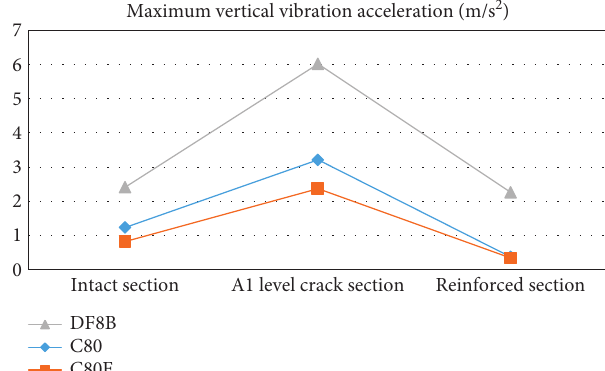
Figure 26: Comparative analysis diagram of maximum vertical acceleration between two rails on the top surface of filling layer under the